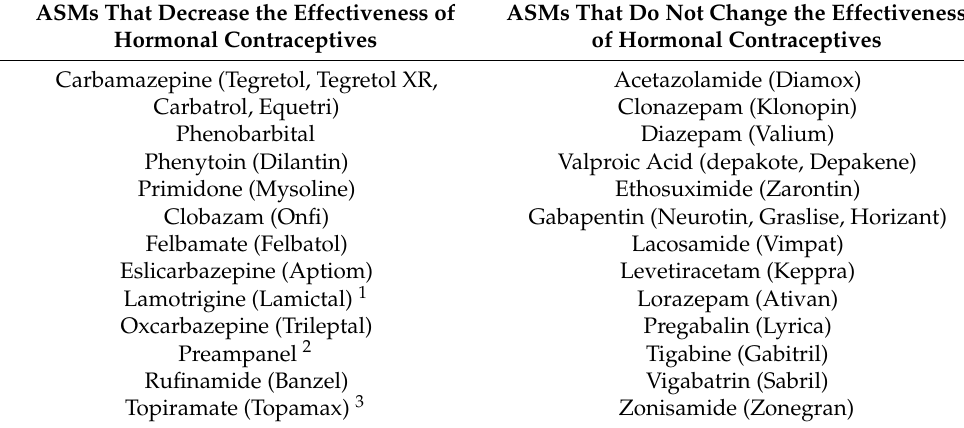
Table 1. List of anti-seizure medications (ASMs) that do and do not affect hormonal contraception through hepatic enzyme